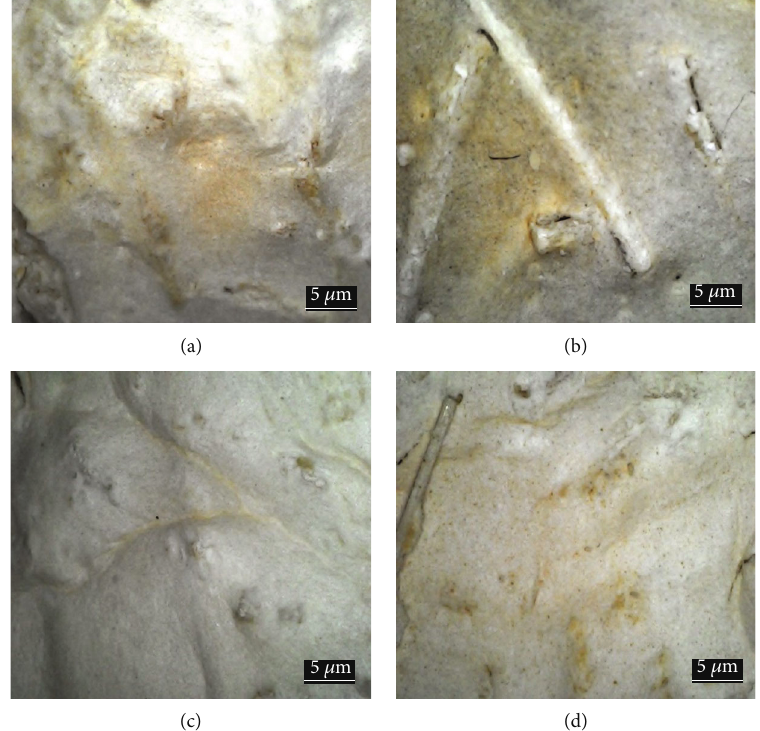
Figure 8: Morphology of surface of biofoam cup with 1600x magnitude: DB-SF1 (a), DB-SF1.5 (b), B-SF1 (c), and B-SF1.5